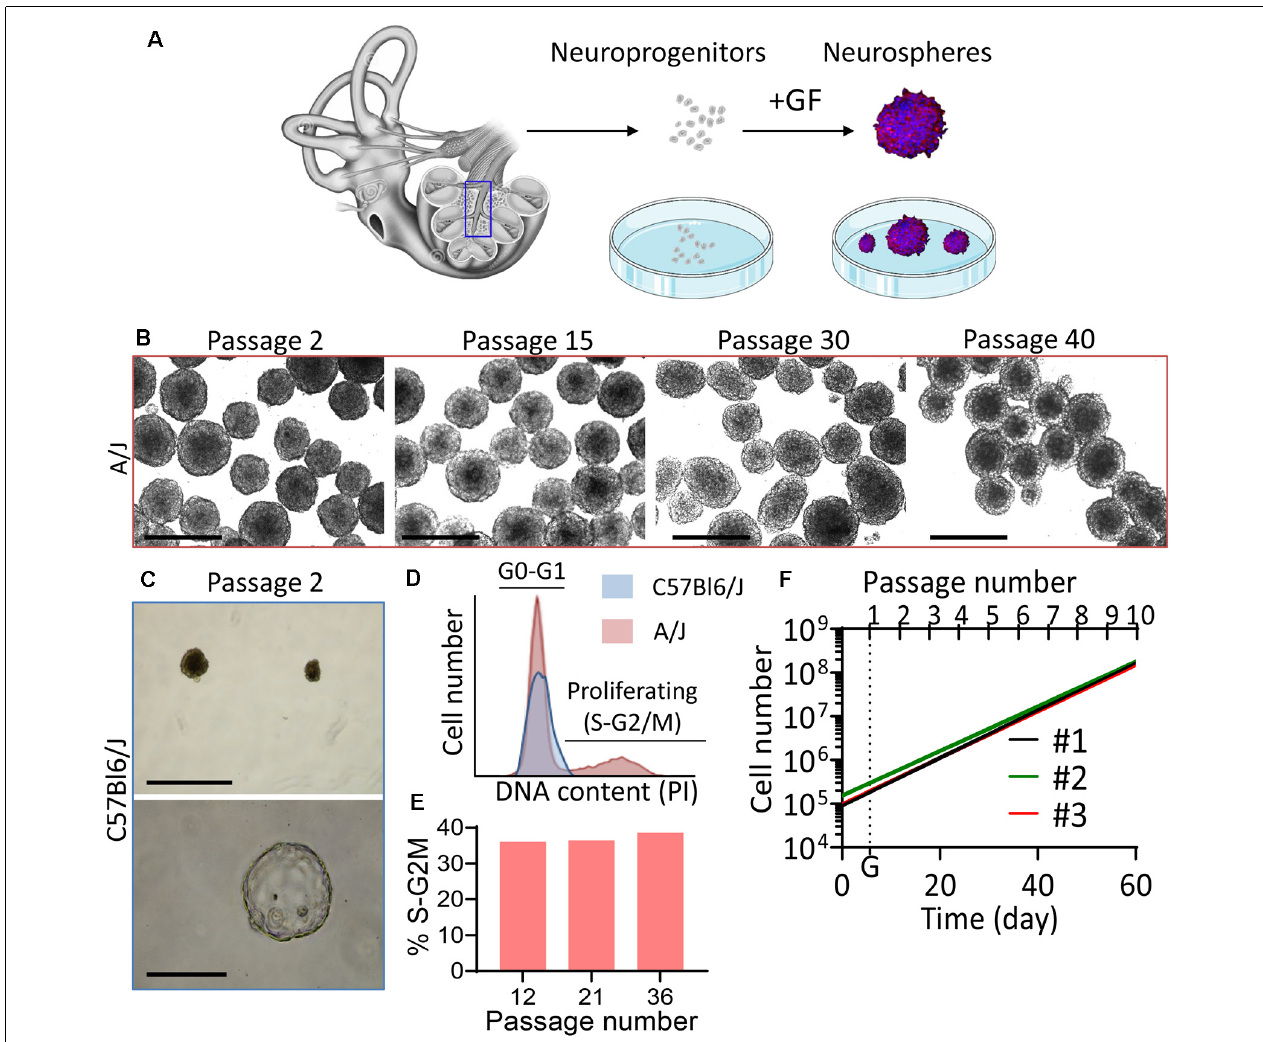
FIGURE 1 | High intrinsic propagation potential of phoenix auditory neuroprogenitors. (A) Auditory neuroprogenitors were isolated from the mouse pup spiral ganglion and cultured as single cell suspension. Upon growth factor addition (FGF, EGF, IGF, heparan sulfate), auditory neuroprogenitors form neurospheres that can be propagated. (B,C) Bright-field microscopy pictures of spheres obtained from (B) A/J and (C) C57Bl6/J P5 mouse pups after 3 days in culture following the indicated passage. (B) Scale bar: 500 µ m. Spheres from C57Bl6/J rapidly reach senescence (upper panel; scale bar: 500 µ m) and some become translucent (hollow) spheres (lower panel; scale bar: 100 µ m). (D) DNA content was quantified by flow cytometry in A/J (red) and C57Bl6/J (blue) auditory neuroprogenitors using propidium iodide (PI) staining. At the fourth passage, A/J neuroprogenitors exhibited more than 35% cells in S/G2-M phases, whereas C57Bl6 were quiescent (100% cells in G0–G1 phases). (E) The proportion of proliferating progenitors remained constant ( > 35%) over passages. Bar graph shows the relative proportion of phoenix neuroprogenitors engaged in S–G2M phases of the cell cycle at passage 12, 21, and 36. (F) The high proliferation rate of phoenix neuroprogenitors was